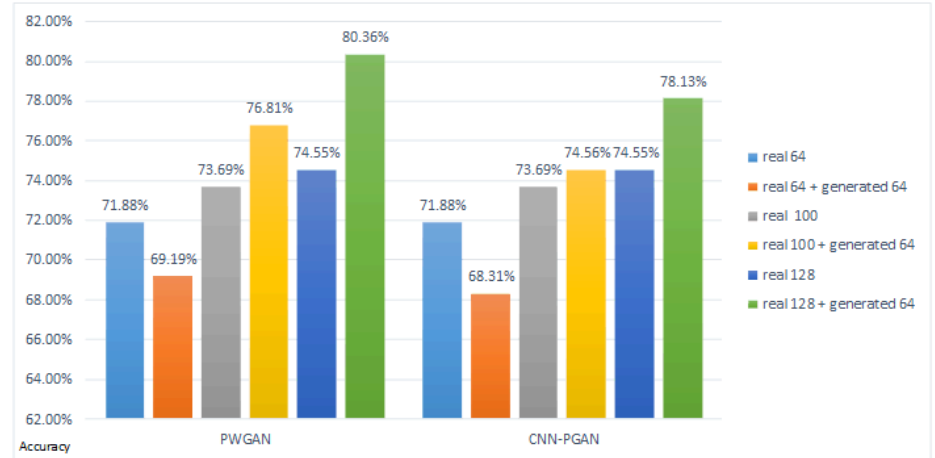
Figure 9. The classification result of different numbers of real images for training the entire network on